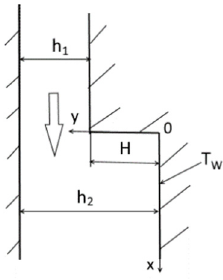
Figure 1. The scheme of the droplet-laden flow in the backward-facing step.